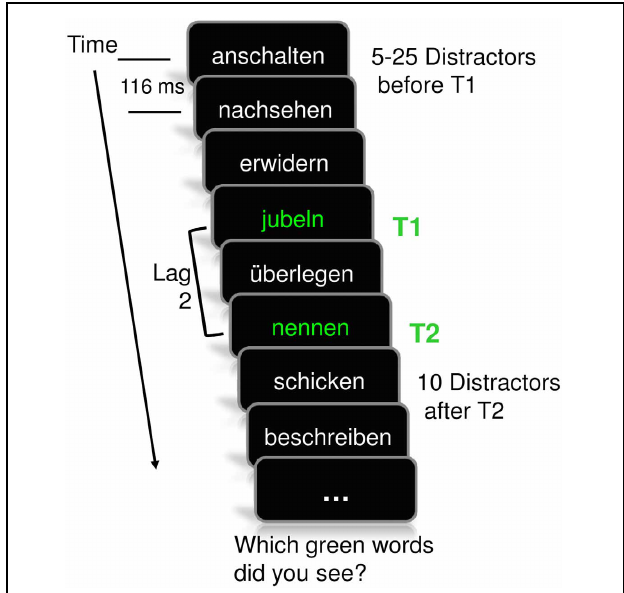
FIGURE 2 | Schematic of the rapid serial visual presentation paradigm, implemented as an attentional blink task. Students were asked to identify two target words occurring in green amidst a series of white words (distractors). The first target (T1) varied in affective value (arousing pleasant, neutral, arousing unpleasant), while the second target (T2) and the distractors were always neutral in content. Each trial included a baseline period of distractors, varying in number, before T1 was displayed. T2 was followed by another sequence of distractors. The temporal distance within the target doublet was 232ms (one intervening distractor) or 696ms (five intervening distractors), reflecting lags 2 and 6, respectively. The present example illustrates a trial with an engaging pleasant T1 in the lag 2 condition. Note: anschalten, to turn on; nachsehen, to check back; erwidern, to respond; jubeln, to cheer; überlegen, to reason; nennen, to name; schicken, to send; beschreiben, to